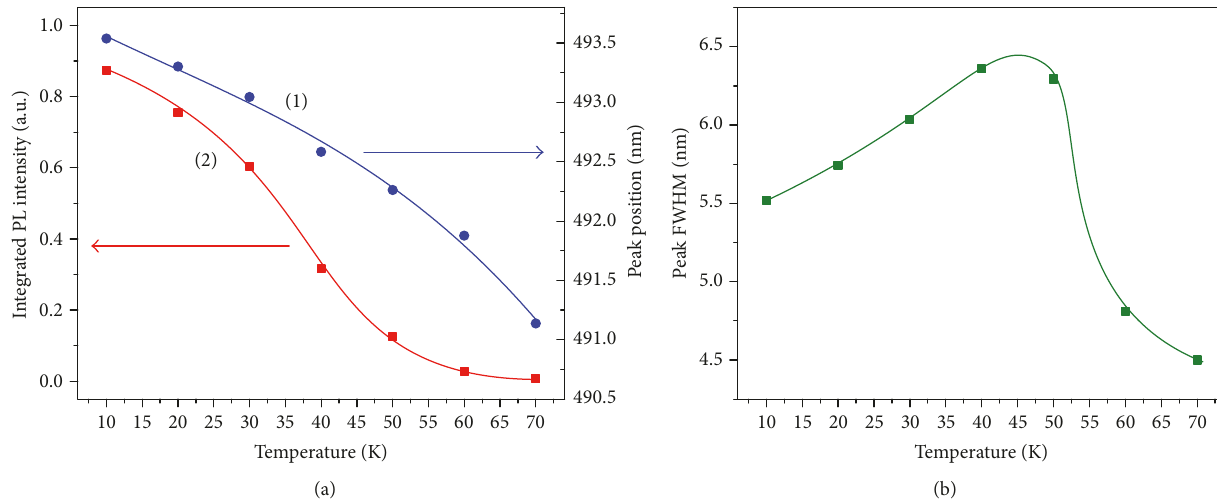
Figure 5: Dependence of exciton PL on temperature. (a) The temperature dependence of the integrated intensity and the peak position of PL exciton E band. (b) The temperature dependence of the FWHM value of E band.